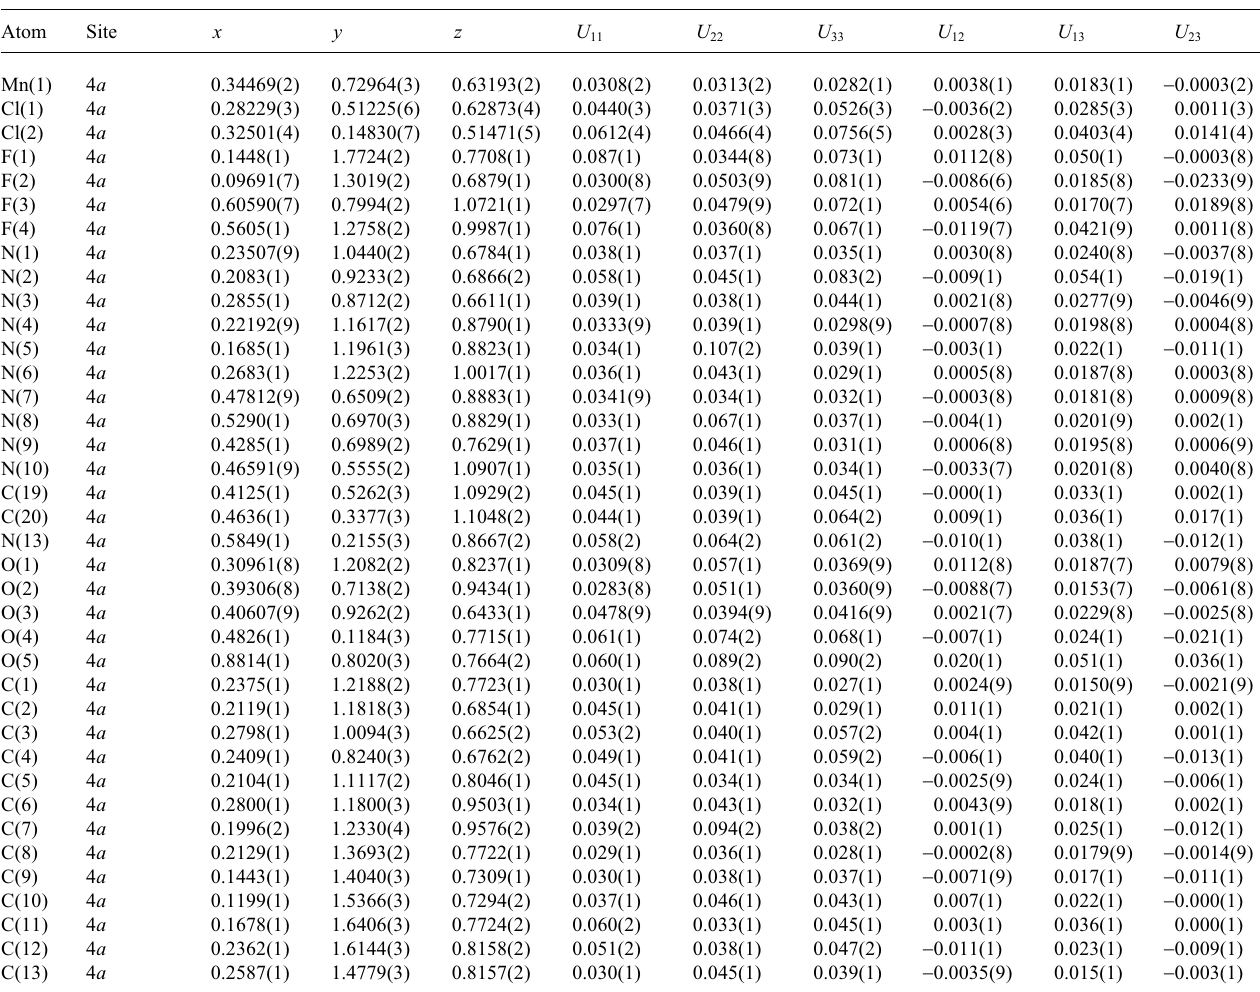
Table 3. Atomic coordinates and displacement parameters (in Å 2 ).